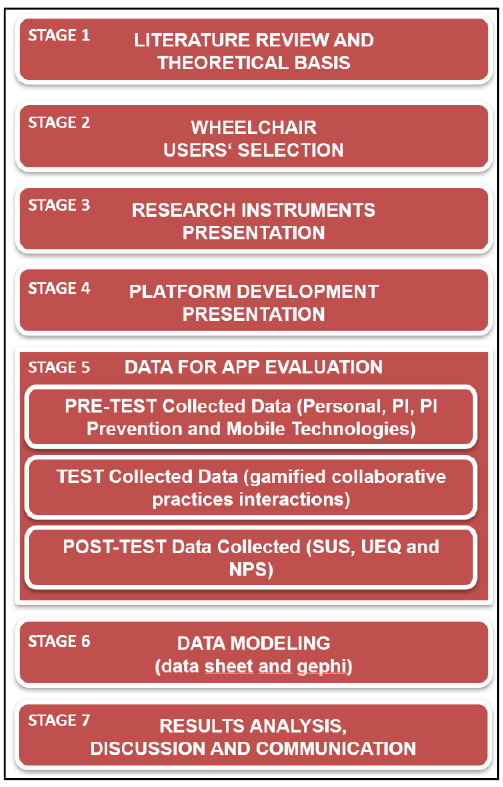
Figure 1. Research